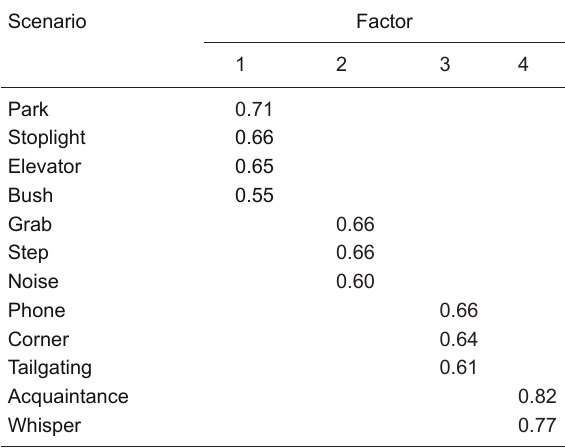
Table 4. Principal axis factor analysis and factor analysis loading following Varimax